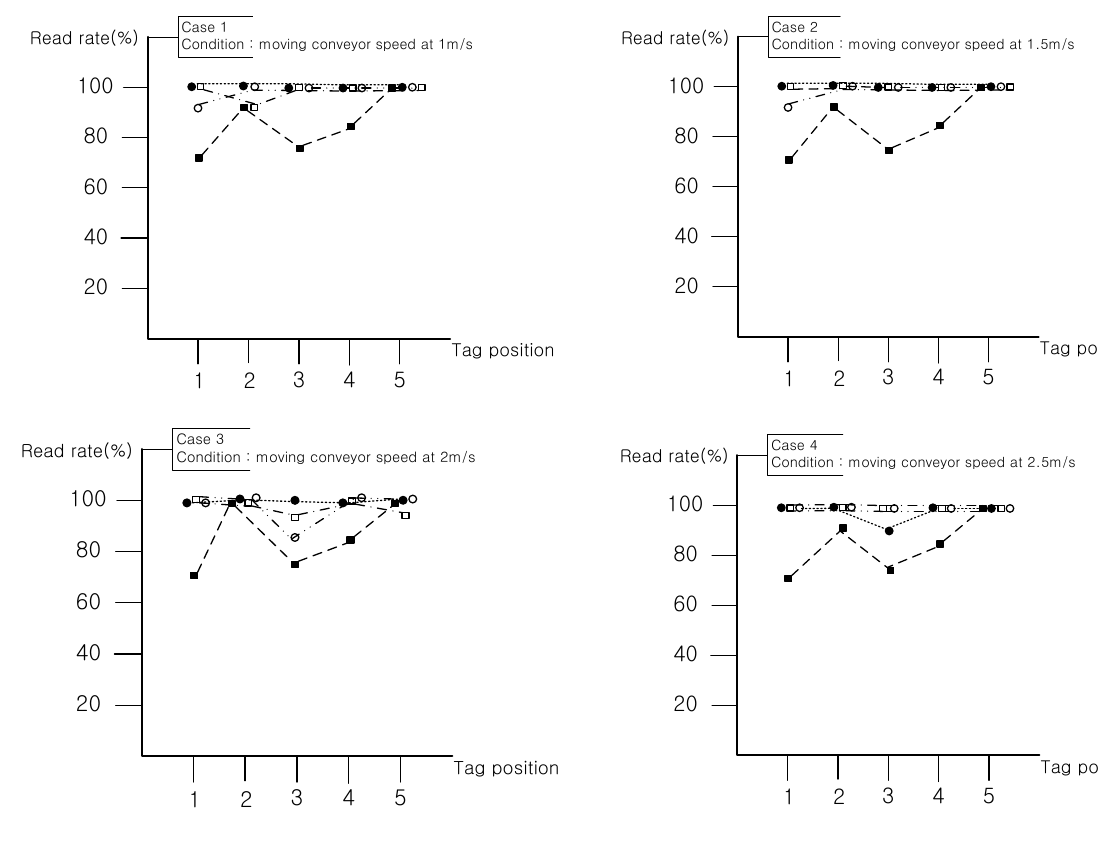
Figure 9. The experimental results of four different case studies using two types of